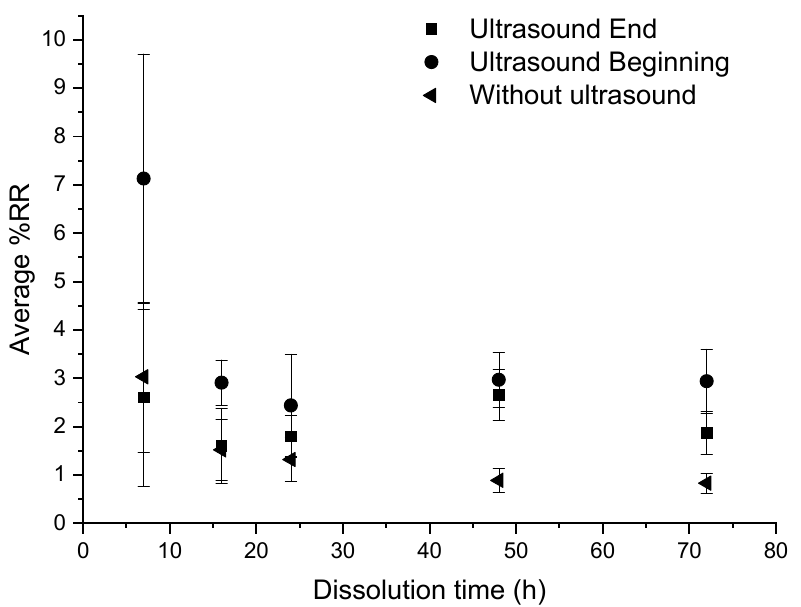
Figure 11. Influence of different ultrasonic conditions on the average % RR as a function of dissolution time for composite: acetone ratio of 1:4.